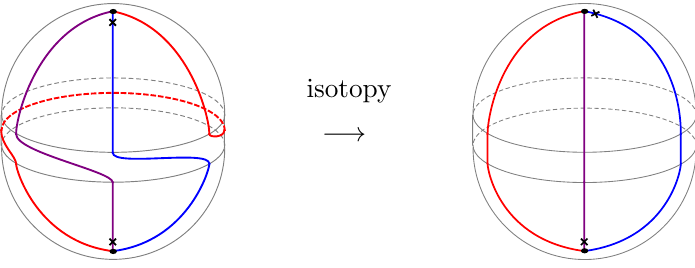
Figure 24 . The cyclic permutation map on the cylinder (left) is related to the cyclic permutation map on the junction vector (right) by an isotropy transformation of the TDLs, sweeping through the upper